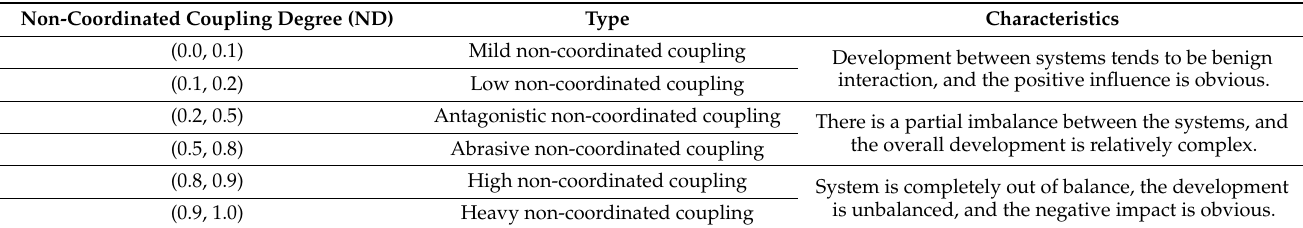
Table 4. Phase division of uncoordinated coupling.